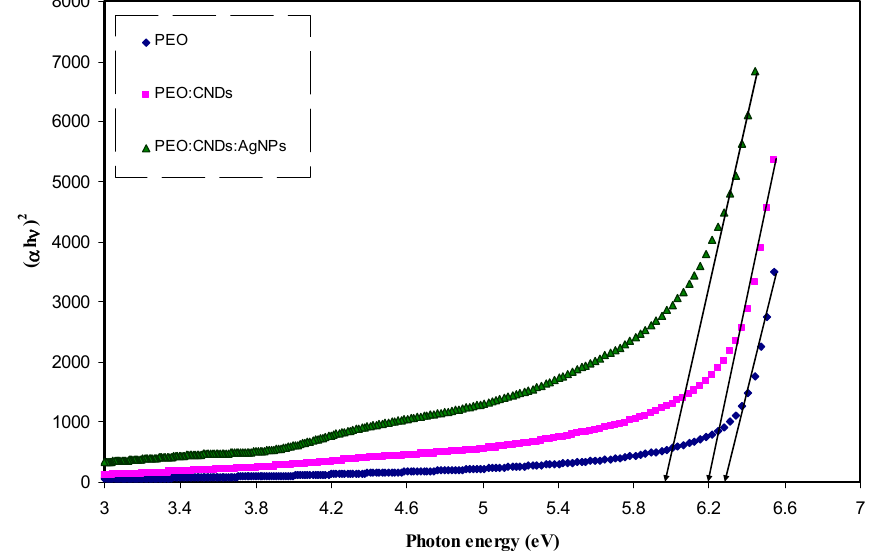
Figure 9. Plot of ( α h υ ) 2 vs. photon energy for pure PEO (PEPN0), PEO:CNDs (PEPN1), and PEO:CNDs:Ag (PEPN2) composite samples.